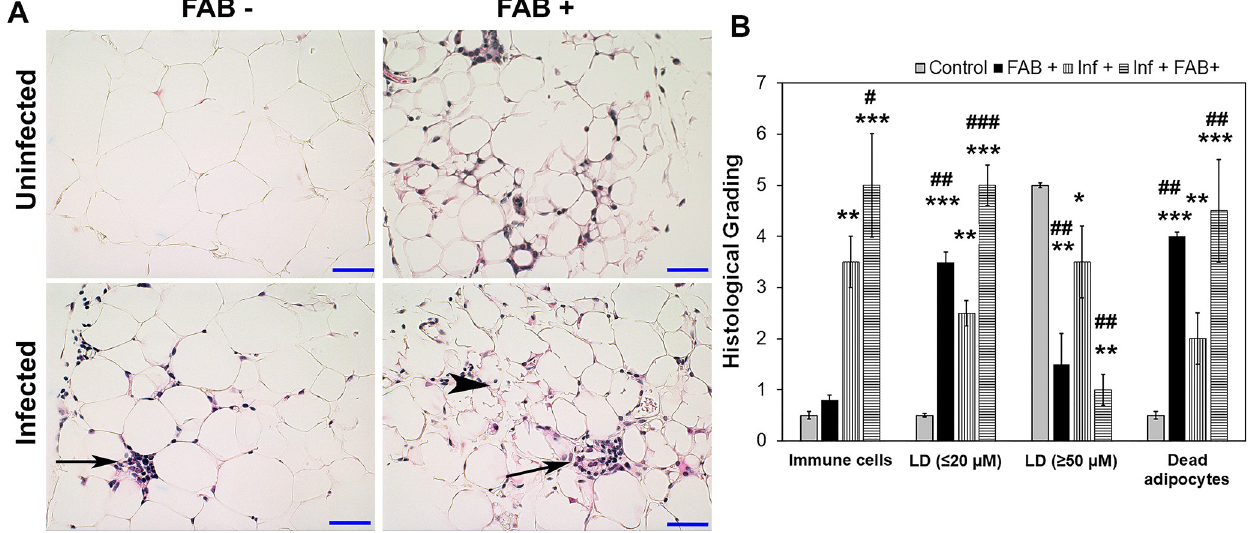
Fig 3. T . cruzi infection alters adipose tissue pathology and fat-ablation further increases infiltration of immune cells into adipose tissue in FAT-ATTAC mice during early chronic stage (90 DPI). A. Hematoxylin and eosin (H&E) staining of adipose tissue in indicated mice (infected or uninfected mice, fat-ablated (Fab +) or fat-unablated (Fab-) n = 5). Infiltration of immune cells, long black arrow; multi-ocular lipid droplets/smaller size lipid droplets, black arrowhead. Bar = 50 μ m, 20x magnification. B. Histological grading of adipose tissue pathology was carried out according to experimental groups and classified in terms of degree of infiltrated immune cells, size of adipocytes (micro-lipid droplets � 20 um, and macro-lipid droplets � 50 um), and number of dead adipocytes in adipose tissue during chronic T . cruzi infection and/or fat ablation (5 images per section/mouse in each group. Each class was graded on a six-point scale ranging from 0 to 5+ as discussed in Method section and presented as a bar graph. The values plotted are mean ± standard deviation (SD) from n = 5. � p � 0.05, �� p � 0.01 or ��� p � 0.001 compared with uninfected fat-unablated. # p � 0.05, ## p � 0.01 or ### p � 0.001 compared with infected